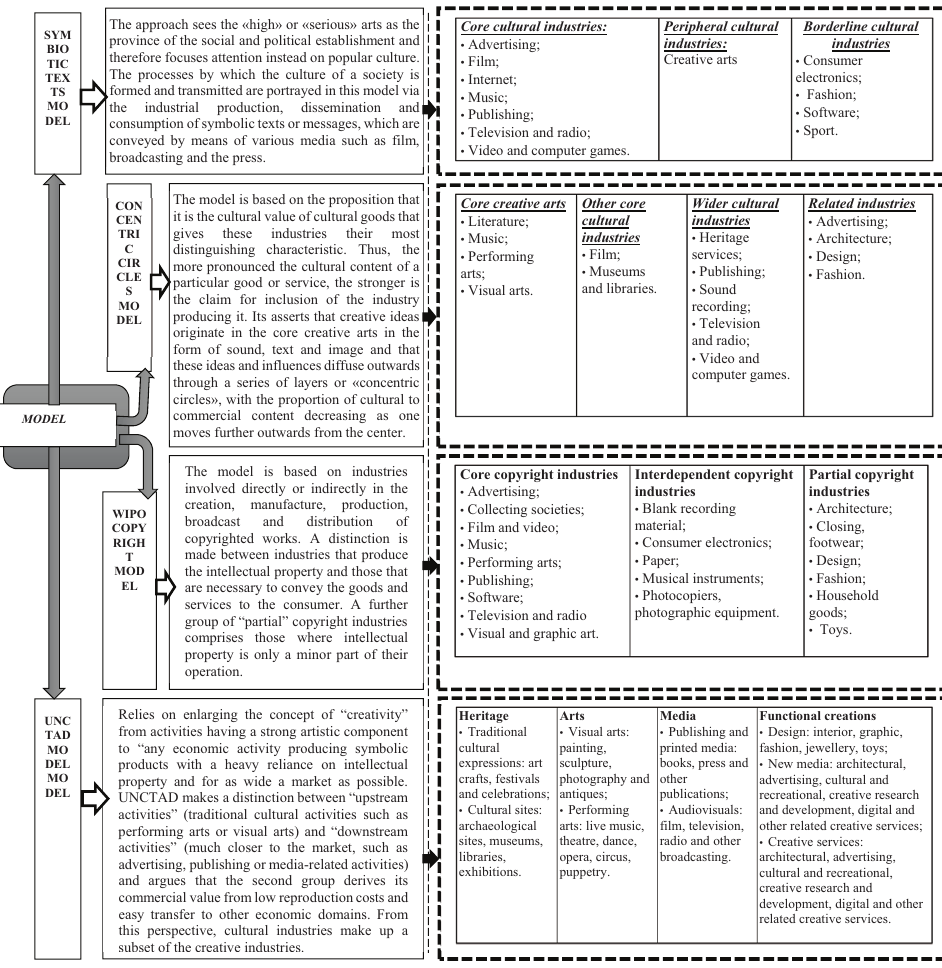
Figure 4. Classification systems for the creative industries from different models (source: created by